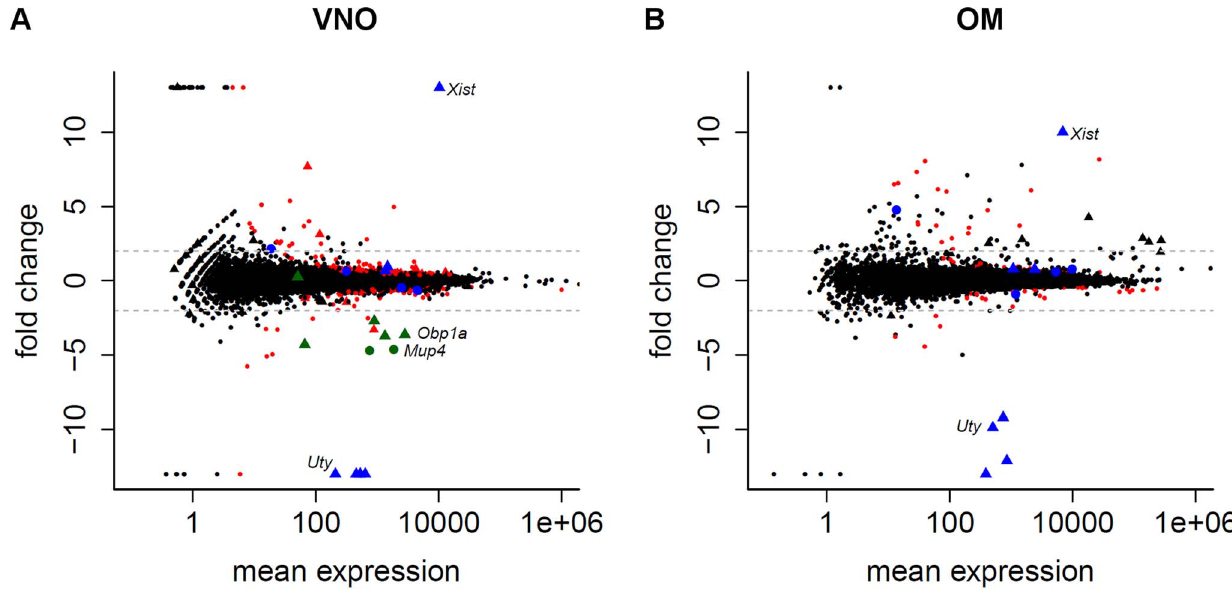
Figure 3. Limited sexual dimorphism in the olfactory system. The mean gene expression is plotted against their log 2 fold change between male and female samples for the VNO (A) and OM (B). Genes with 6 infinite fold changes were assigned to 6 13 to ease visualization. Triangles depict genes located on the sex chromosomes. Genes significantly differentially expressed in one tissue (FDR 5%) are red while the 11 genes that are significantly differentially expressed in both tissues are blue. The genes in the VNO plotted in green are eight lipocalins that are highly variable between replicates. Dotted lines indicate a log 2 fold change of 6 2.